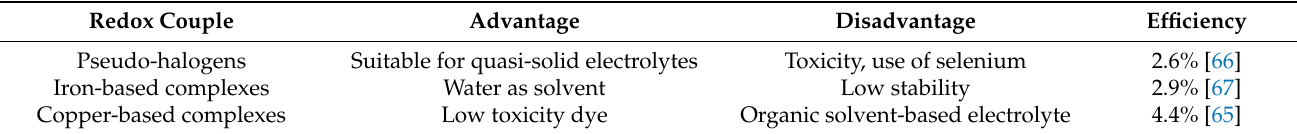
Table 4. Examples of relevant redox couples in DSSC research, their advantages and disadvantages, and reported efficiencies. Redox